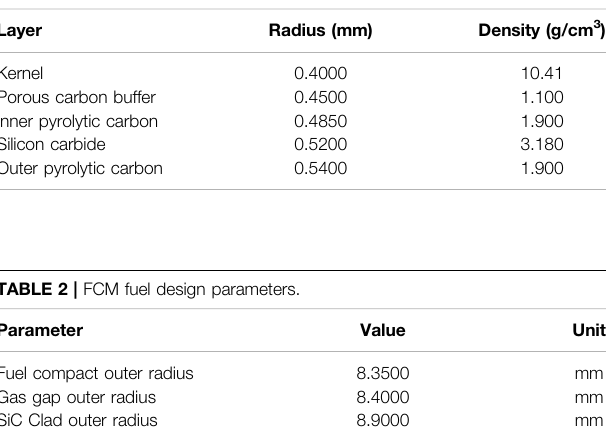
TABLE 1 | TRISO particle geometry and composition.